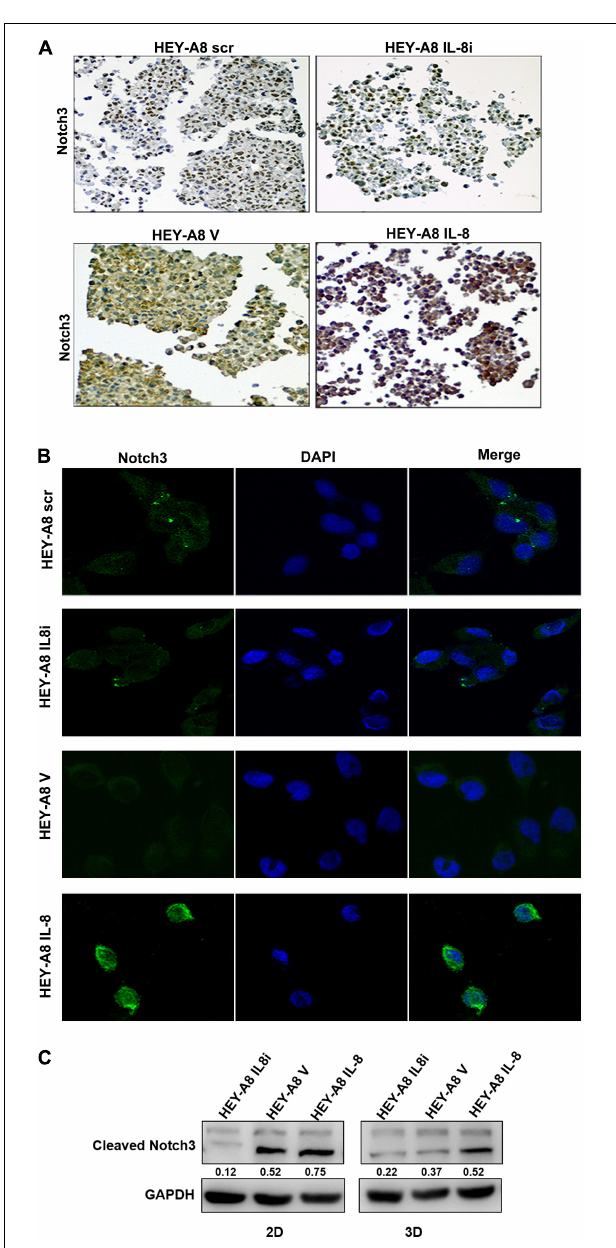
FIGURE 5 | IL-8 enhances ovarian cancer cell stemness through the Notch3-mediated signaling pathway. (A) Examination of Notch3 expression in spheroids by immunocytochemistry. (B) Notch3 activation in cells derived from spheroids. Notch3 was activated (green) in 3-D culture cells with IL-8 overexpression but was decreased in IL-8-silencing cells compared with control cells. DAPI (blue) was used as a nuclear dye. (C) Analysis of cleaved Notch3 by Western blotting in HEY-A8 cells cultured in 2-D and 3-D. IL,